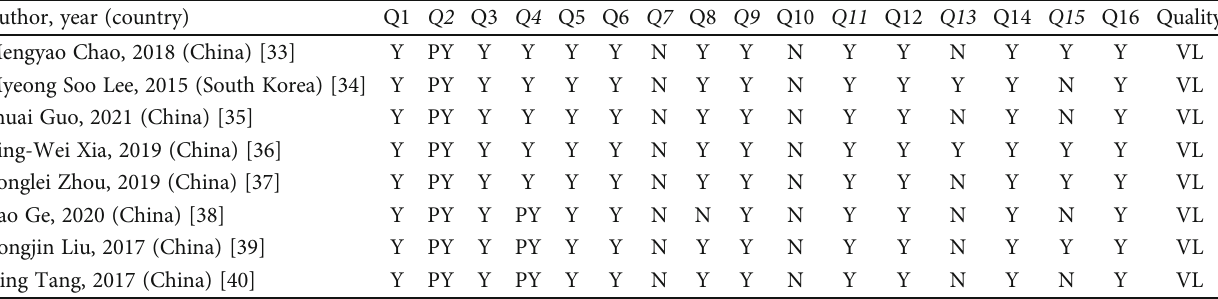
Table 3: Result of the AMSTAR-2 assessments. Note: Y: yes; PY: partial yes; N: no; VL: very low; L: low. Note: key items are marked in italic. Author, year (country)